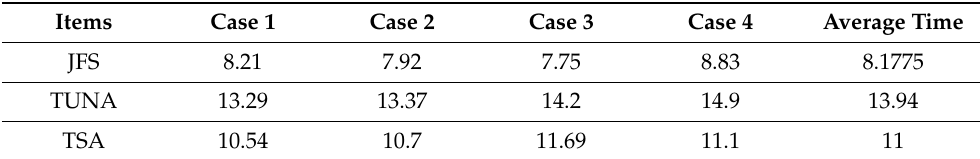
Table 4. Average computational time in seconds of the proposed JFS, TUNA & TSA.